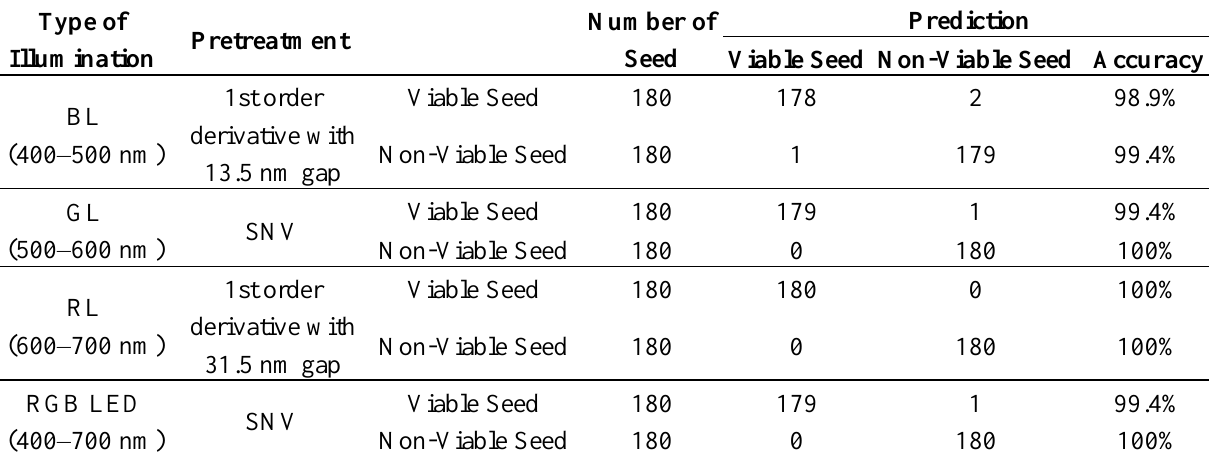
Table 5. Discrimination between viable and nonviable pepper seeds using PLS images and the PLS-DA